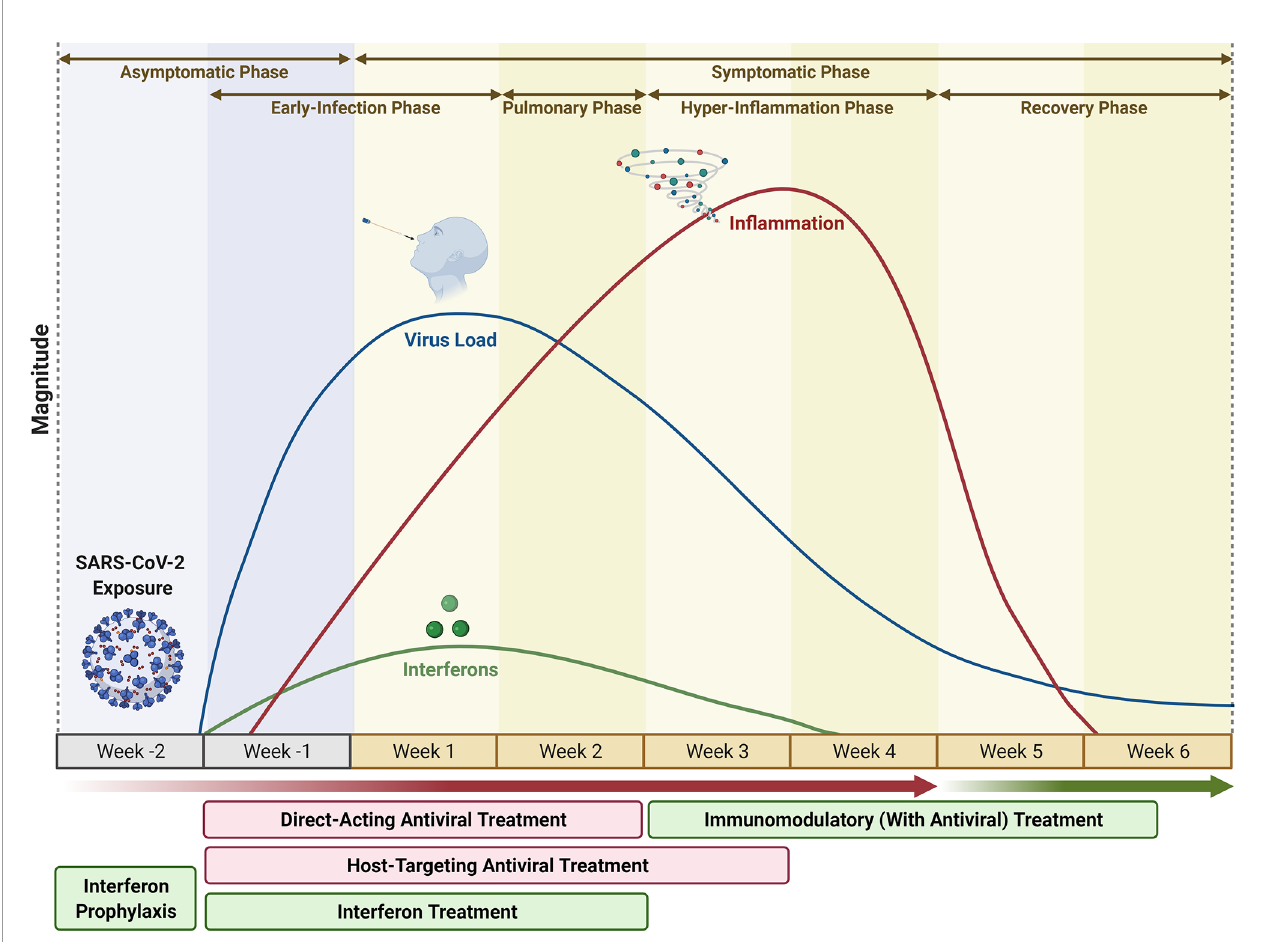
FIGURE 1 | COVID-19 Progression vs Treatment Options. The infection phase of COVID-19 begins 1-week post exposure to SARS-CoV2 (Asymptomatic phase) and lasts for 4 weeks from the time of onset of symptoms, marked by a steady increase and resolution in virus titer between the fi rst 2 weeks, during which Direct- Acting Antivirals (DAA), alone or in combination with Host-Targeting Antivirals (HTA) or Recombinant Interferons, could be potential treatment options. Week-2 until week-4 marks the resolution of infection phase, and onset of pulmonary phase (week-1, week-2) followed by in fl ammatory phase (week-3, week-4), during which Immunomodulators, mostly in combination with Antivirals, could be potential treatment options. Interferon Prophylaxis could be a preventive strategy on suspected exposure to SARS-CoV2 during the asymptomatic, pre-infection phase. (Timecourse not to be exactly scaled; varies depending on patient heterogeneity and virus variant). Figure modi fi ed from (135), and created with